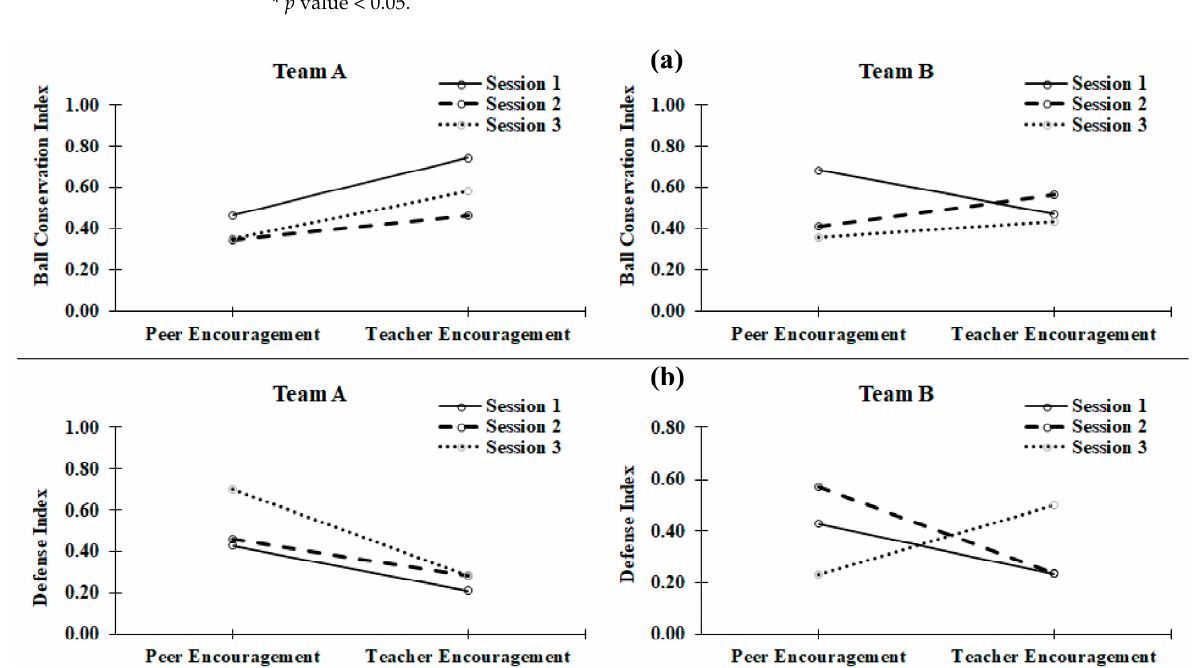
Figure 1. ( a ) The effects of two different modalities of verbal encouragement on ball conservation index (BCI); ( b ) the effects of two different modalities of verbal encouragement on defensive efficiency index (DEI).